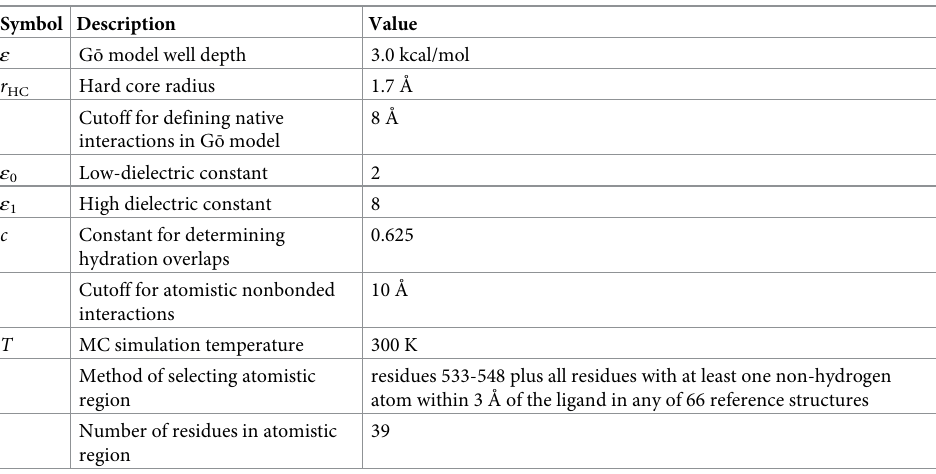
Table 1. Parameters of the